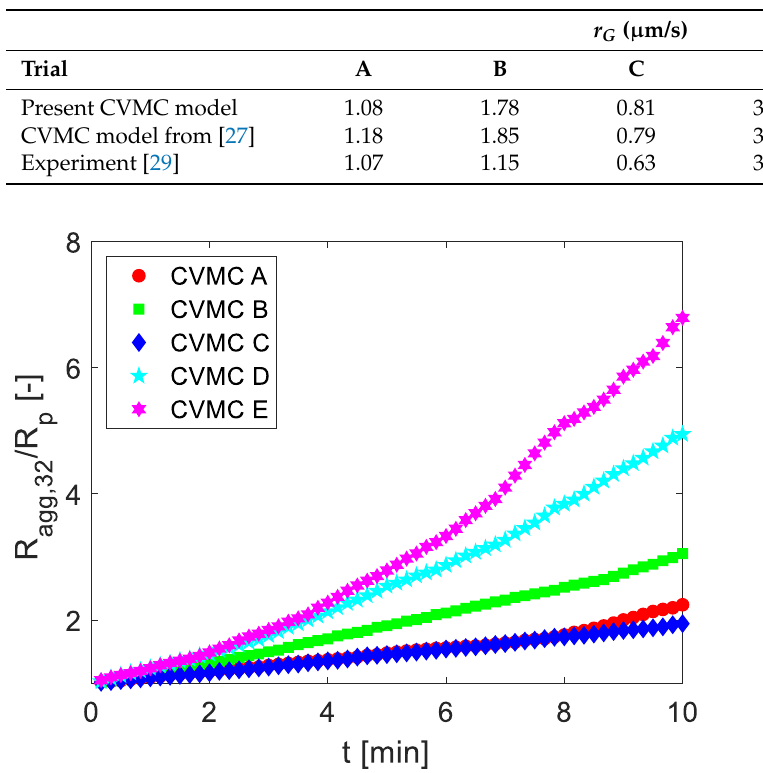
Table 3. The overall growth rate of different experiments and corresponding simulations by employing the present CVMC model and the CVMC model from [27] after 10 min.